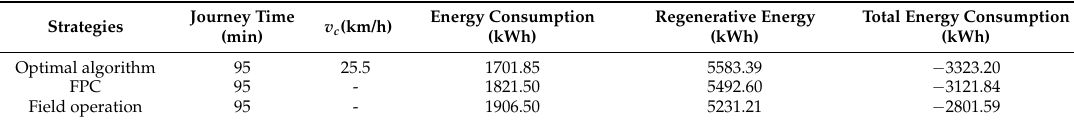
Table 4. Simulation results of the three strategies.